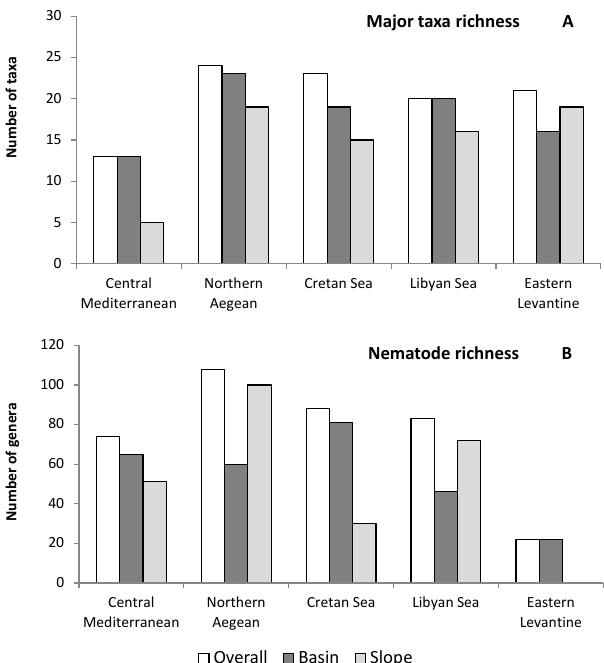
Fig. 4. Meiofauna diversity per studied area and habitat based on (A) major meiofaunal taxa, (B) nematode genera. The overall bar indicates the richness per area when both habitats are combined.